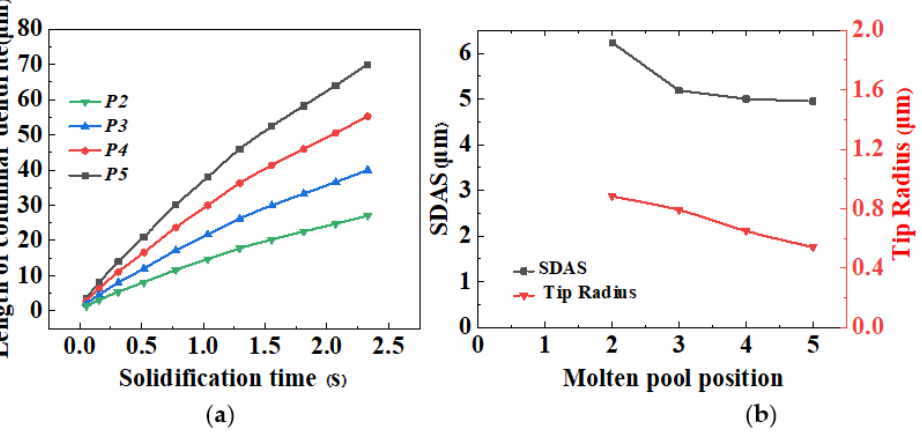
Figure 10. ( a ) Length of columnar dendrites and ( b ) secondary dendrite arm spacing and tip radius in different positions of the molten pool.